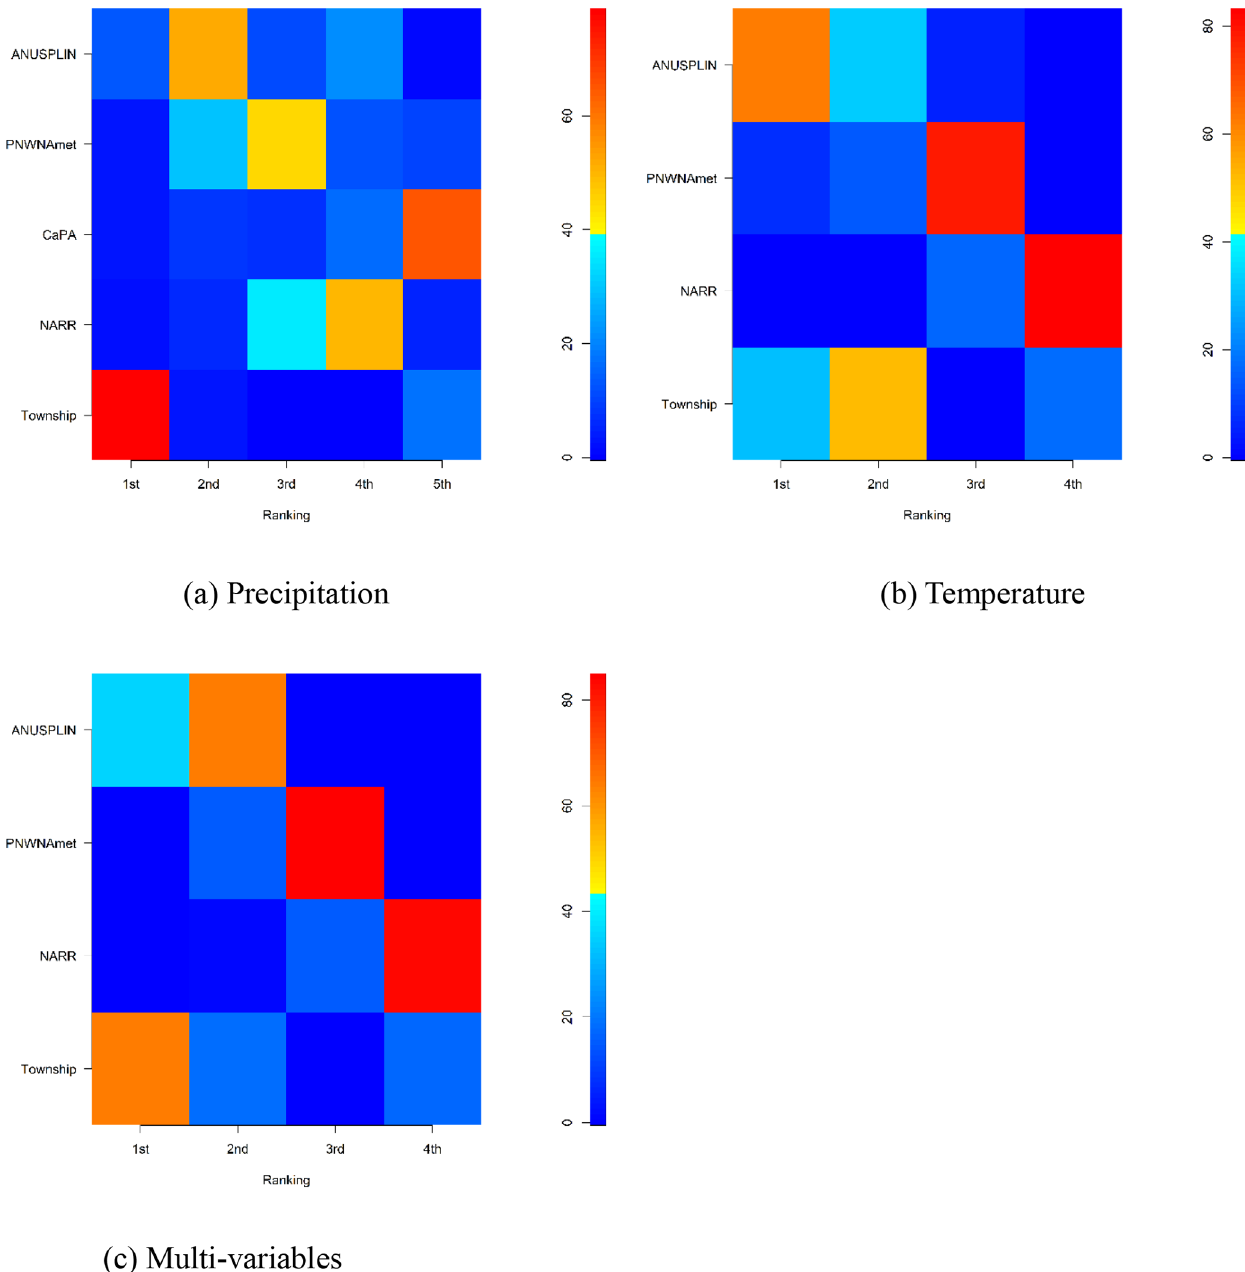
Figure 10. Percentage of climate datasets on each rank for R ind and R mul . (a) Precipitation, (b) temperature, (c)